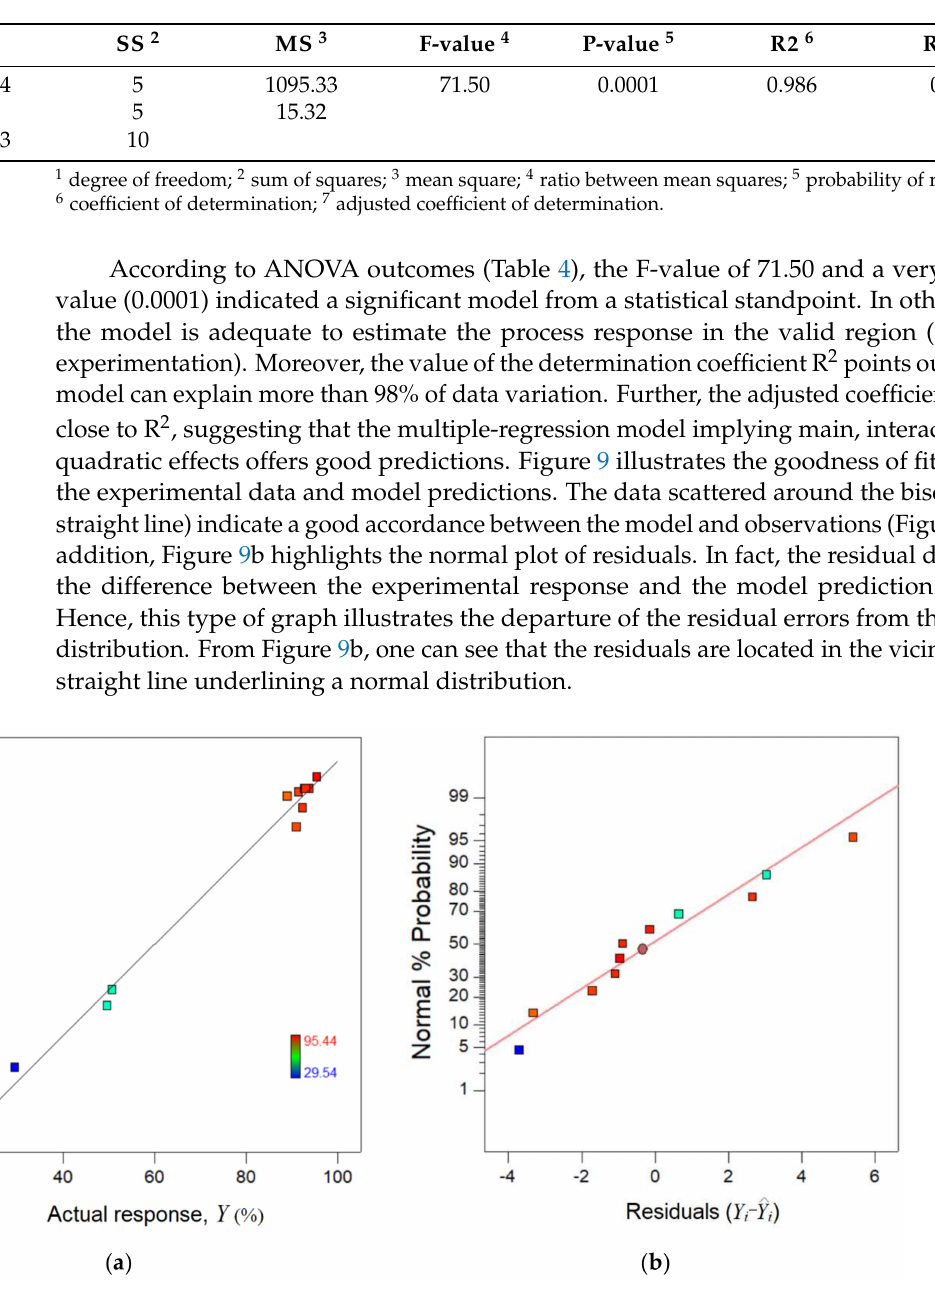
Table 4. Analysis of variance (ANOVA) for the multiple-regression model ˆ Y ( x 1 , x 2 ) .